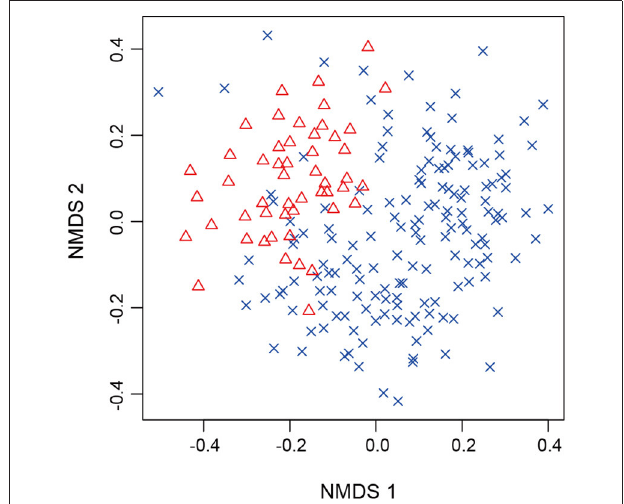
Frontiers in Microbiology |